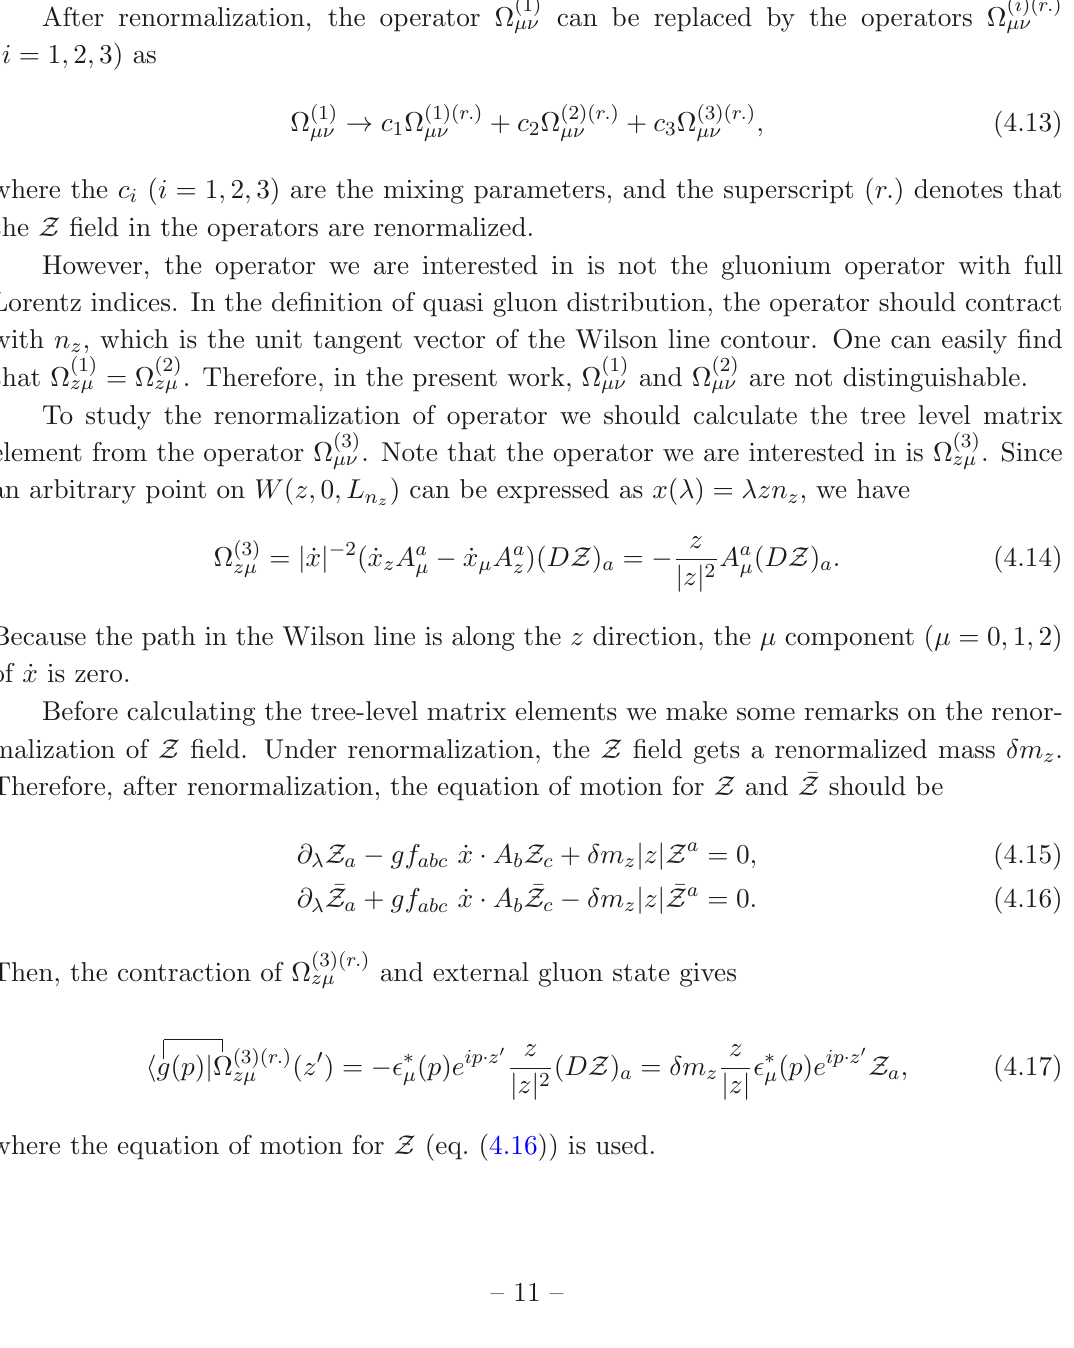
denotes the counter-term from matrix N